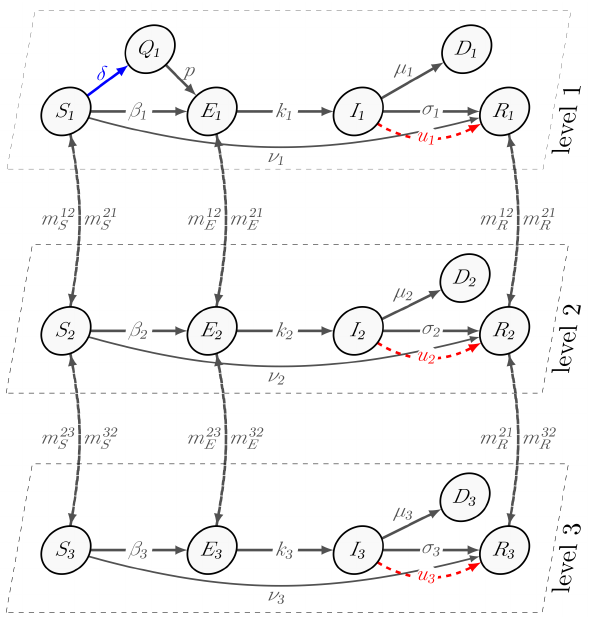
Figure 1. The scheme of transition between groups S , Q , E , I , R , D , and hierarchical